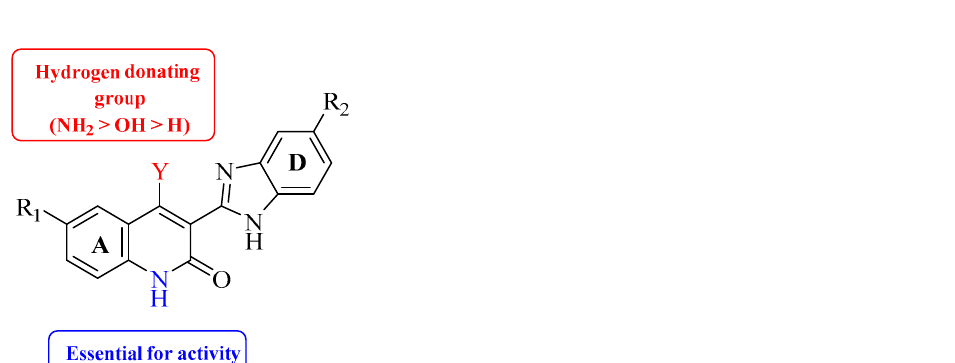
Figure 2. Structure–activity relationship study of 3-benzimidazol-2- ylhydroquinolin-2-one deriva-